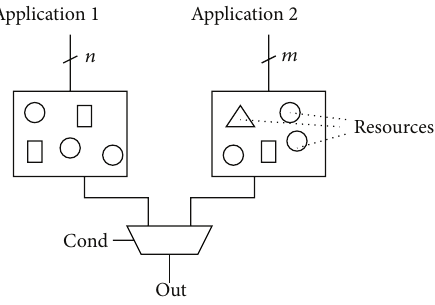
Figure 1: 2 mutually exclusive applications with common